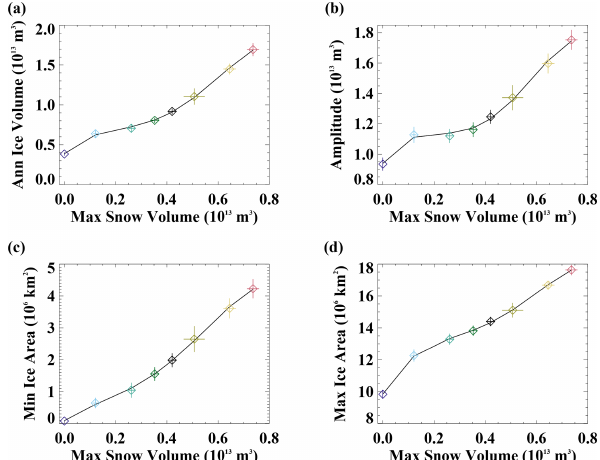
Figure 6. The relationship of the climatological Southern Hemi- sphere (a) annual ice volume, (b) amplitude of the ice volume an- nual cycle, (c) annual minimum ice area, and (d) annual maximum ice area versus the annual maximum snow volume. The diamonds show the simulated mean values, and whiskers are ± 1 standard de- viation across the 20 years analyzed for each simulation. The colors the same as in other figures. The black line is a fourth-order poly- nomial